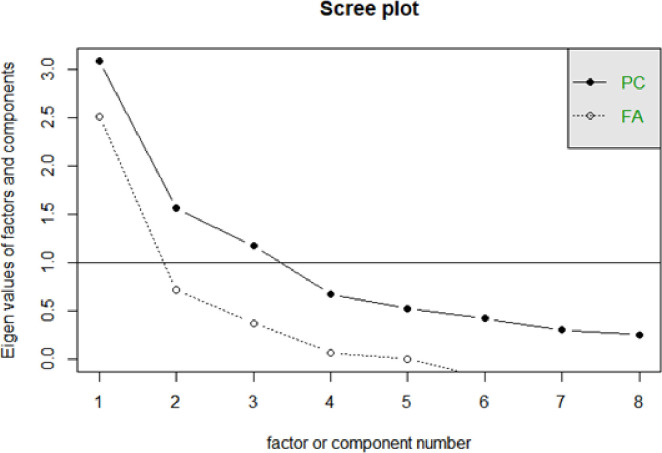
Scree plot para o International Physical Activity Questionnaire (IPAQ).